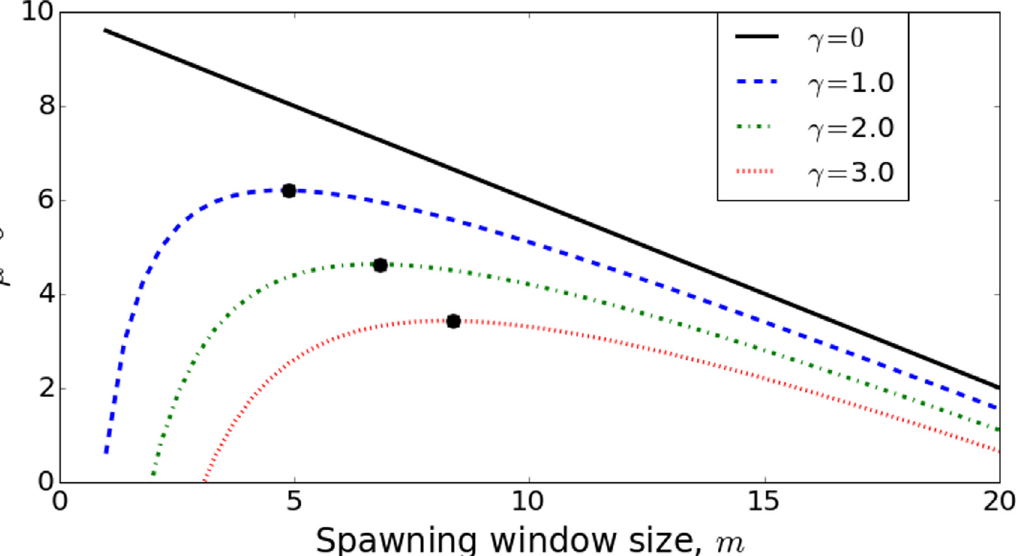
Fig 6. The objective function capturing mean-variance tradeoff, Γ ( m ) = μ ( m ) — γσ 2 ( m ), plotted over a range of spawning window sizes, m , for three distinct values of reproductive resilience, γ . The local maxima represent the values of m that maximizes the objective. Note that each maximum occurs at a unique m , so if m can be observed, γ can be inferred. See S1 Appendix for further analysis of this figure. The functional forms for μ ( m ) and σ ( m ) are taken from S1 Appendix, Eqn. (A6), with parameters [ μ 0 , σ , c] = [10, 3,